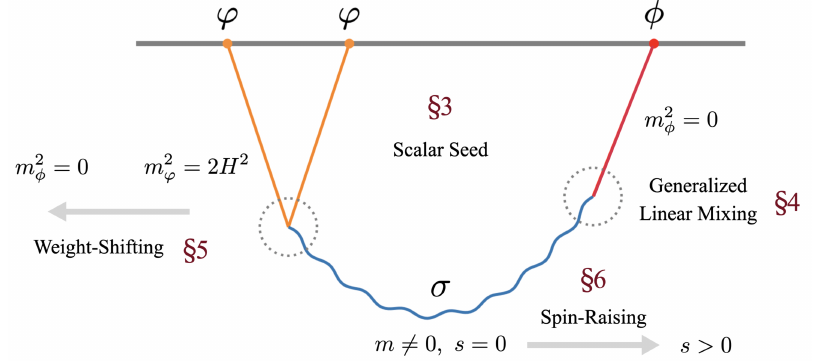
Figure 1 . The structure of this paper. We compute the bispectrum of conformally coupled scalars with a massless scalar that linearly mixes with a massive scalar field. From this building block, and various “weight-shifting” and “spin-raising” operations, we generate a wide variety of inflationary bispectra of phenomenological interest. As we relax the requirement of boost symmetry, the signals can be large enough to be detectable in near-future cosmological surveys. The procedure to obtain the scalar seed, as well as the various weight-shifting moves, are presented in the sections indicated